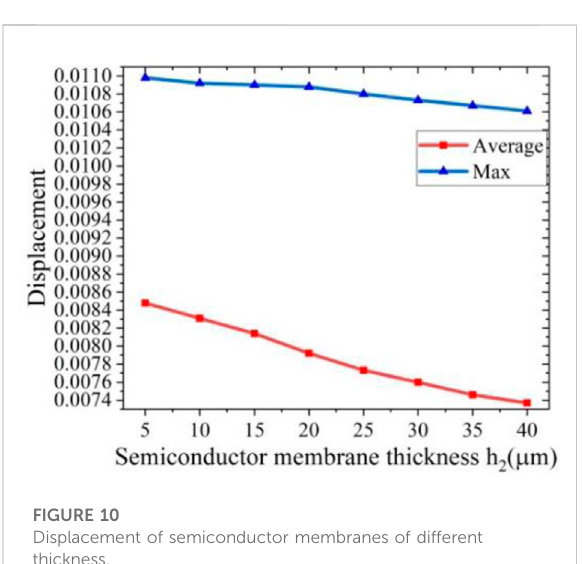
FIGURE 10 Displacement of semiconductor membranes of different